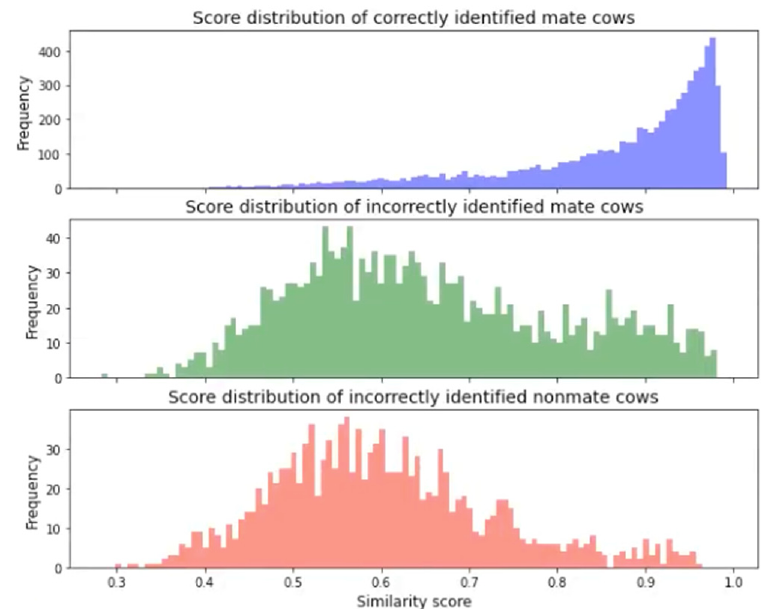
Figure 8. Score distribution in comparison between mate and non-mate cows from closed-set and open-set, respectively.